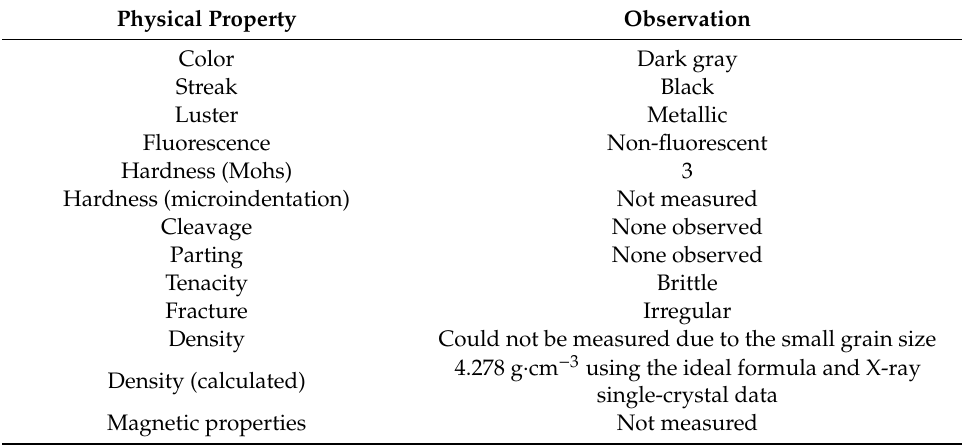
Table 1. Physical properties of